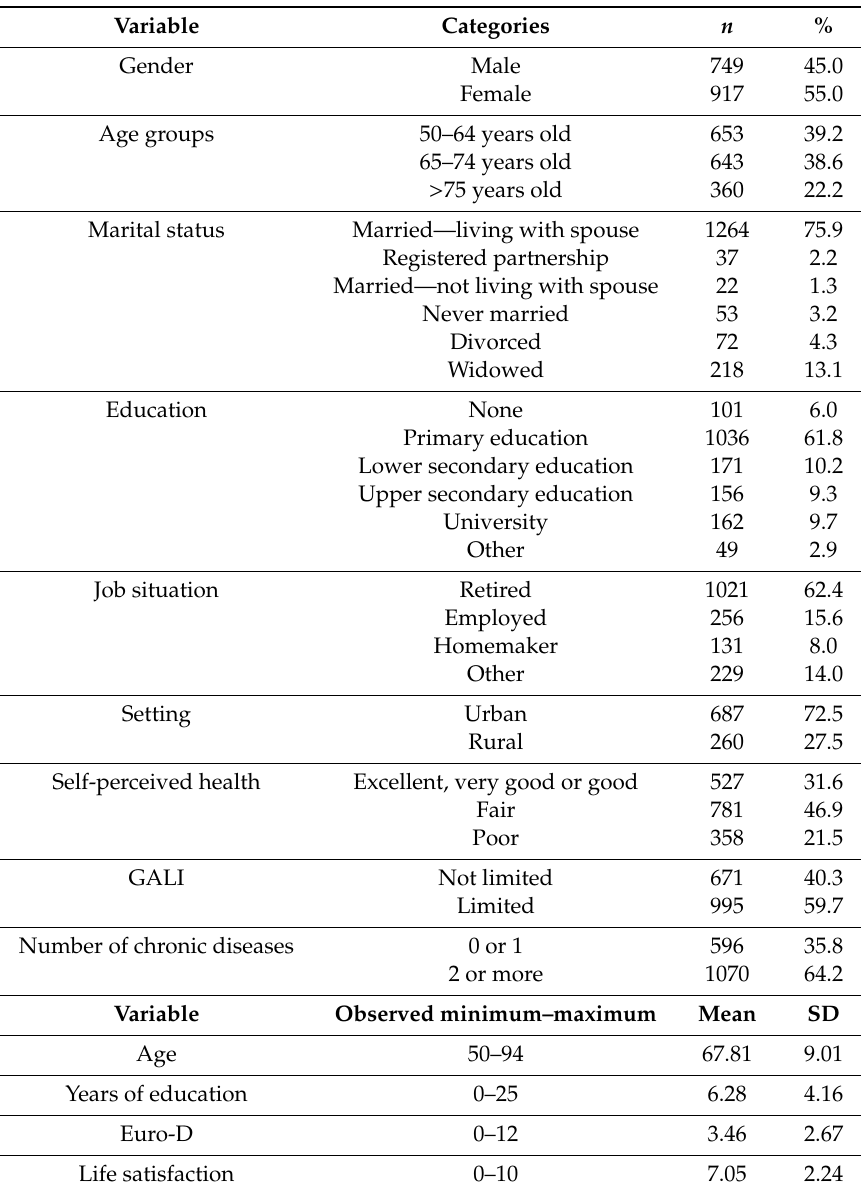
Table 1. Characteristics of the